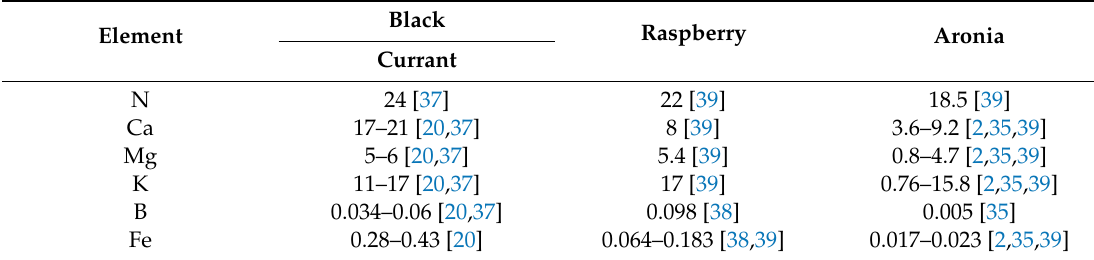
Table 2. Macro- and microelement content in the leaves of black currant, raspberry, and aronia (mg / g